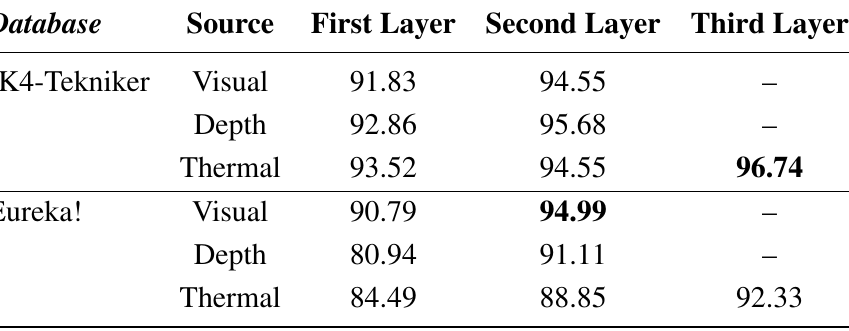
Table 8. Hierarchical multiclassifier: 10-fold cross-validation accuracy percentage obtained selecting each sensor image as the root